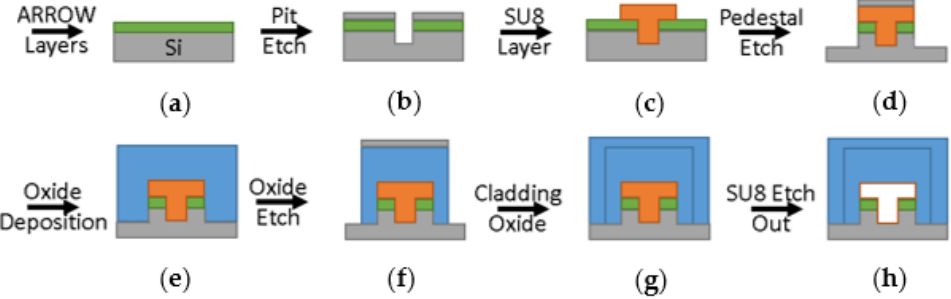
Figure 6. The fabrication flow chart shows cross-section drawing on critical silicon-based microfabrication processes used to build the device, with silicon substrate in gray, thin metal etch masks in gray, anti-resonant reflecting optical waveguide structure (ARROW) layers in green, SU-8 photoresist in orange, and PECVD oxide in blue. ( a ) ARROW layers enable liquid-core waveguiding, and ( b ) the low-pressure chamber (pit) and trench features are etched before ( c ) SU-8 photoresist forms the fluid volume. ( d ) A pedestal helps to improve yield and isolate the optics and ( e ) PECVD oxide forms the walls. ( f ) The liquid-core and solid-core waveguides are etched and ( g ) cladding PECVD oxide protects it all. ( h ) Finally, acid removes the sacrificial SU-8 photoresist, leaving the channels hollow.